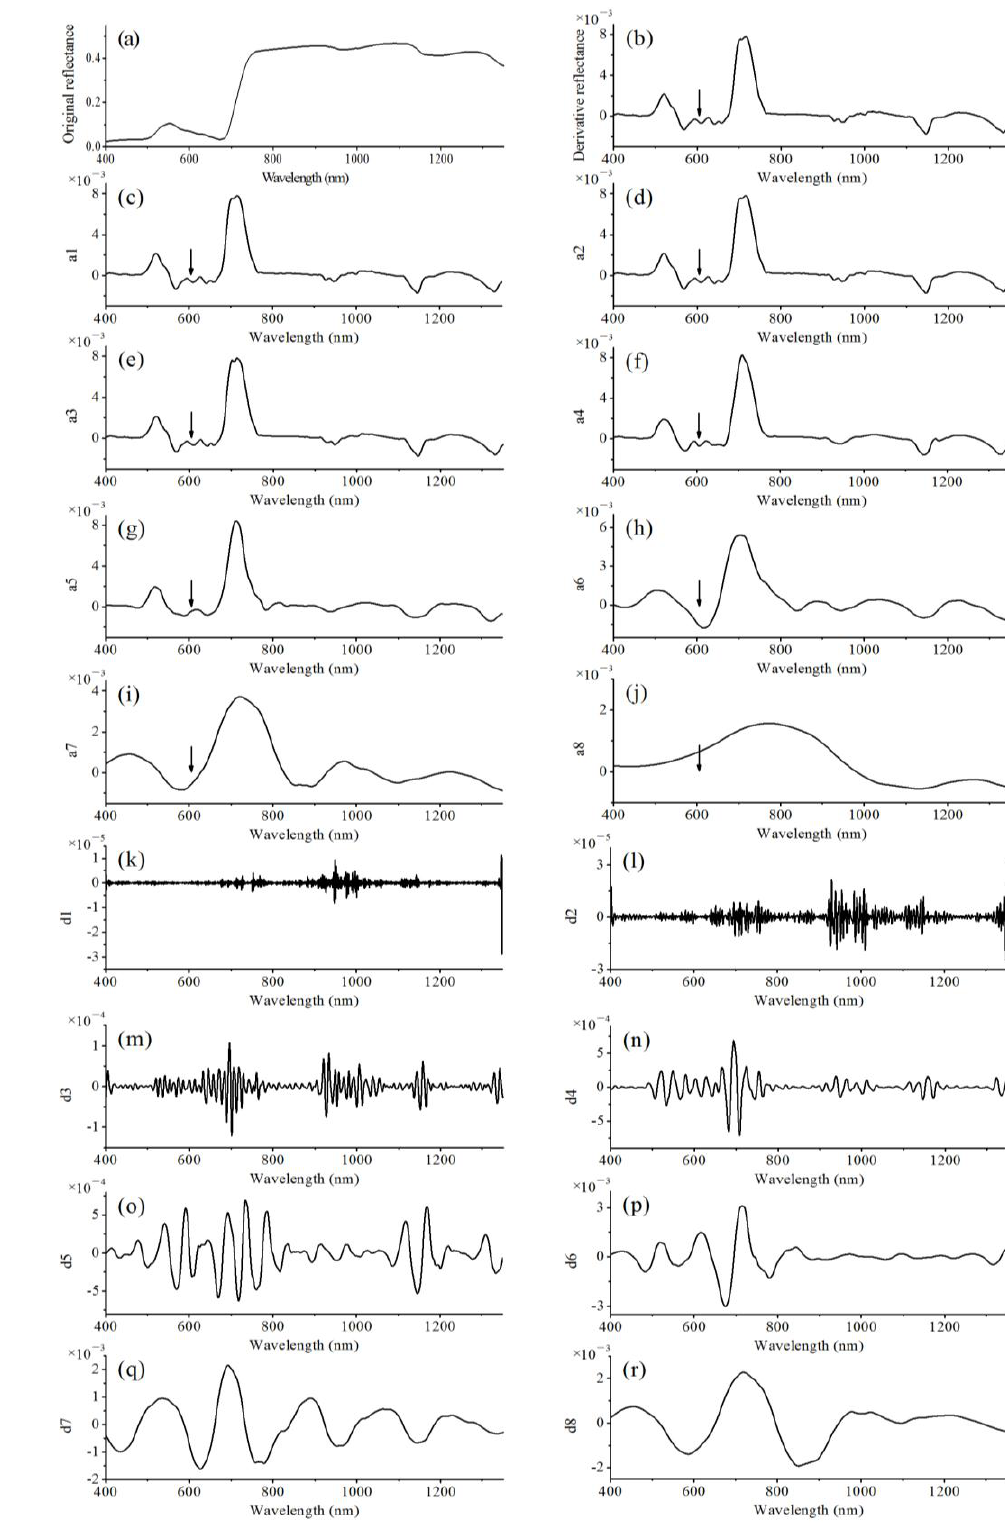
Figure 5. One example (Sample 1) of plots of original reflectance ( a ), derivative reflectance ( b ), reconstructed approximation reflectance at the first to eighth decomposition level ( c − j ) and reconstructed detail reflectance at the first to eighth decomposition level ( k − r ) using discrete wavelet transform (db5 was the mother wavelet